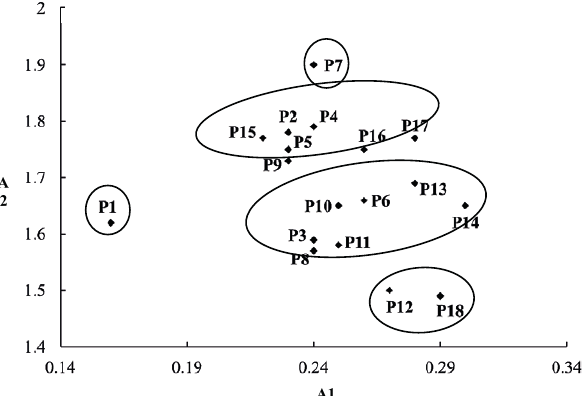
Figure 4. Scatter plot of intrachromosomal (A1) and interchromo- somal (A2) asymmetries of 18 Iranian Ferula assa-foetida L. popu-